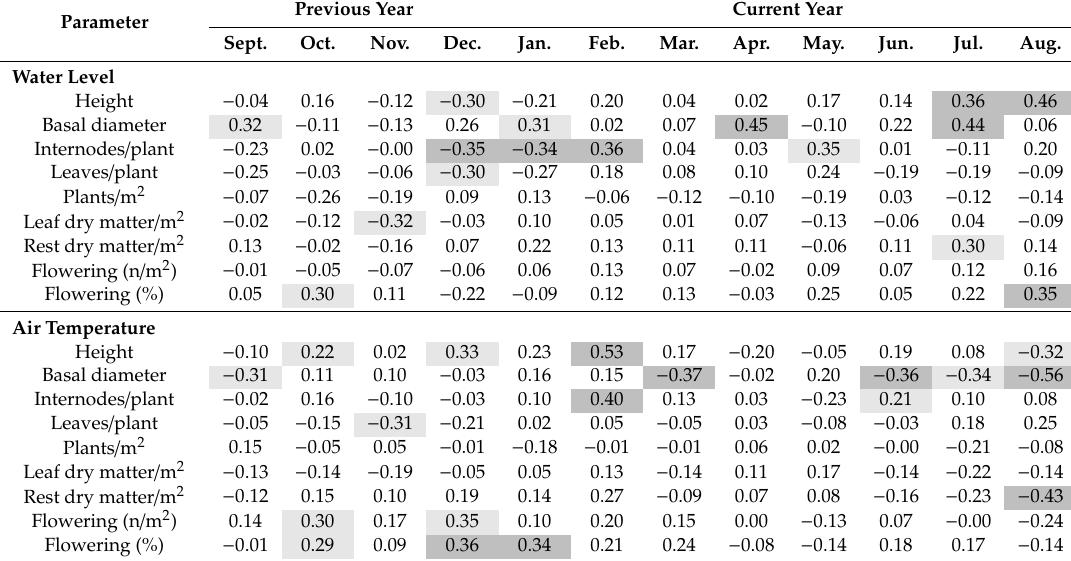
Shaded fields contain statistically significant coe ffi cients (light grey: 0.01 ≤ p ≤ 0.05; dark grey: p ≤